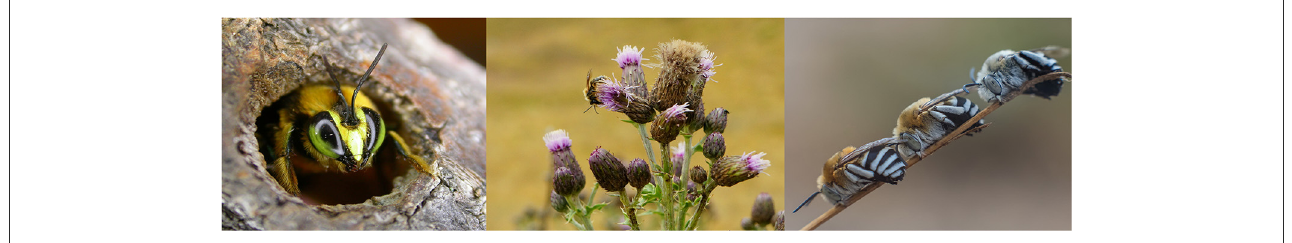
FIGURE1 Charismatic bees of Australia and New Zealand. Xylocopa aerata (Australia, Remko Leijs) , Leioproctus fulvescens (New Zealand, Jay Iwasaki), and Amegilla sp. (Australia, David Marquina Reyes).